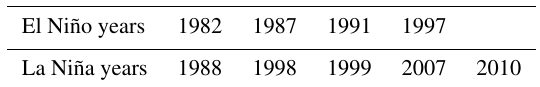
Table 2. List of El Niño events and La Niña events in our study